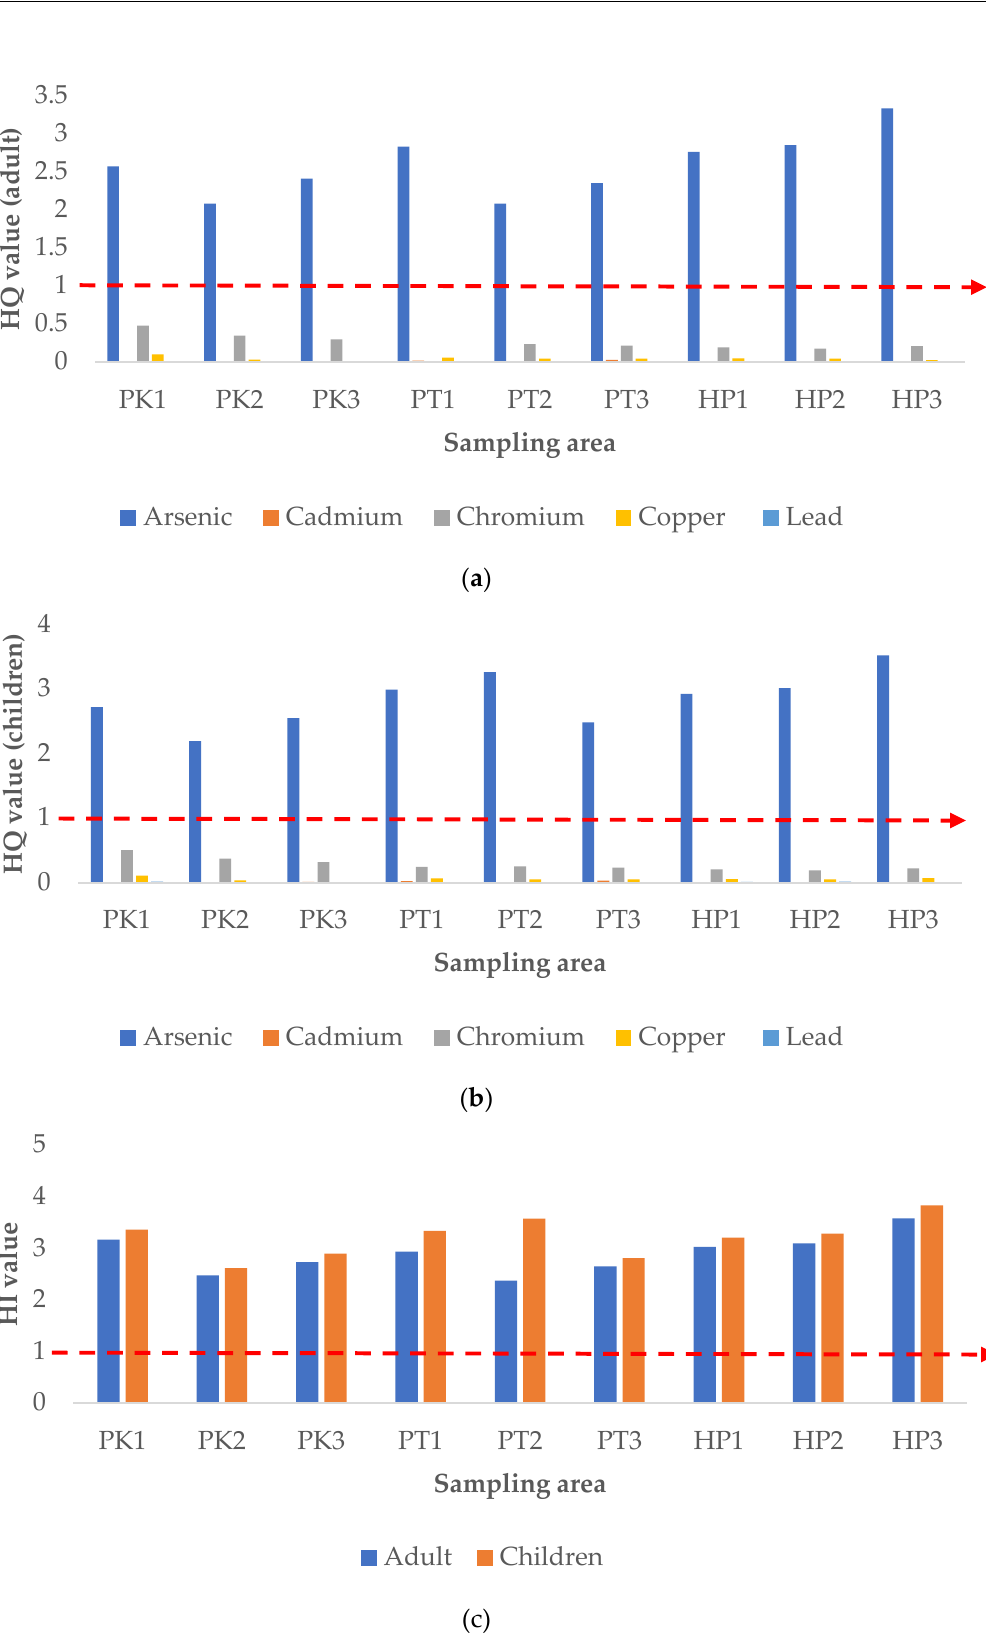
Figure 4. Hazard quotient (HQ, ( a , b )) and hazard index (HI, ( c )) of heavy metals for adult and children through rice consumption. P1K, Plot 1 Kerian; P2K, Plot 2 Kerian; P3K, Plot 3 Kerian; P1PT; lot 1 Perak Tengah; P2PT, Plot 2 Perak Tengah; P3PT, Plot 3 Perak Tengah; P3PT, Plot 3 Perak Tengah; P1HP, Plot 1 Hilir Perak; P2HP, Plot 2 Hilir Perak; P3HP, Plot 3 Hilir Perak.